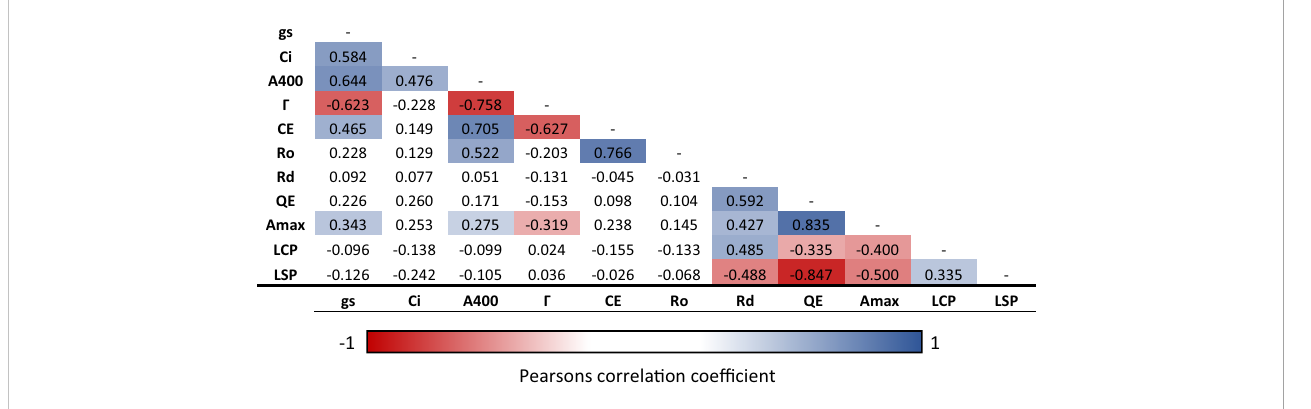
FIGURE 3 Correlation matrix of photosynthetic traits of rice WT and mutant lines. Traits include assimilation rate at ambient CO 2 (A400), internal CO 2 concentration (Ci) and stomatal conductance (gs) was calculated from spot measurements, CO 2 compensation point ( G ), carboxylation ef fi ciency (CE) and total respiration (Ro) calculated from ACi curves; and maximum assimilation rate (A max ), quantum use ef fi ciency (QE), light compensation point (LCP), light saturation point (LSP) and dark respiration (Rd) calculated for light response curves. Statistically signi fi cant (p < 0.05) negative linear correlations are shown in red, signi fi cant positive correlations are shown in blue, insigni fi cant correlations are left blank.